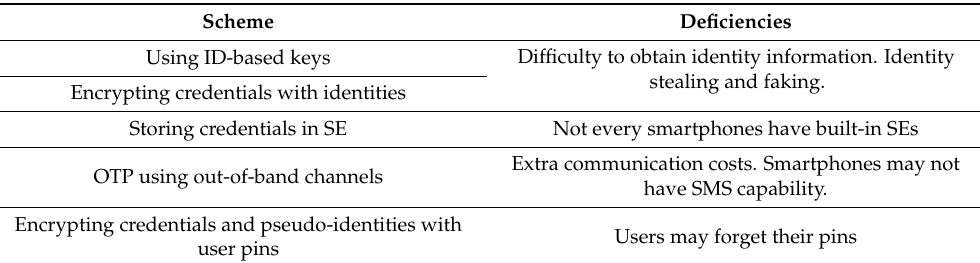
Figure 3. Generalized model of BLE-based applications associated with IoT devices. Table 1. List of Schemes to Pair Smartphones to Devices.